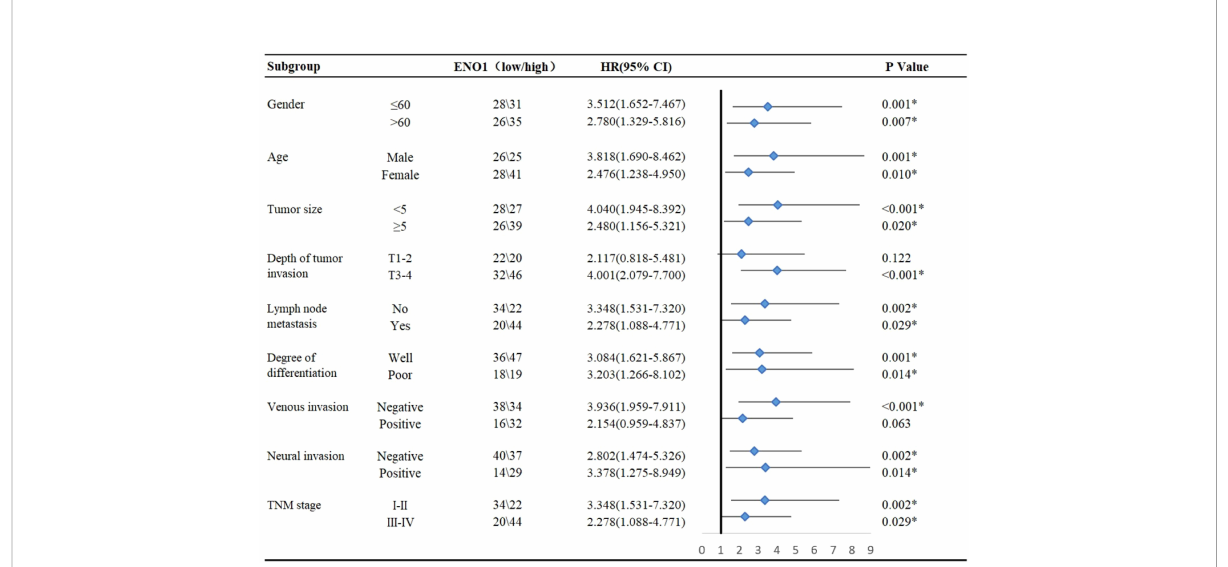
FIGURE 2 Subgroup analysis for the in fl uencing factor of survival among colorectal cancer patients according to ENO1 expression. Statistical analyses were performed via two-tailed Student t test. *, P ≤